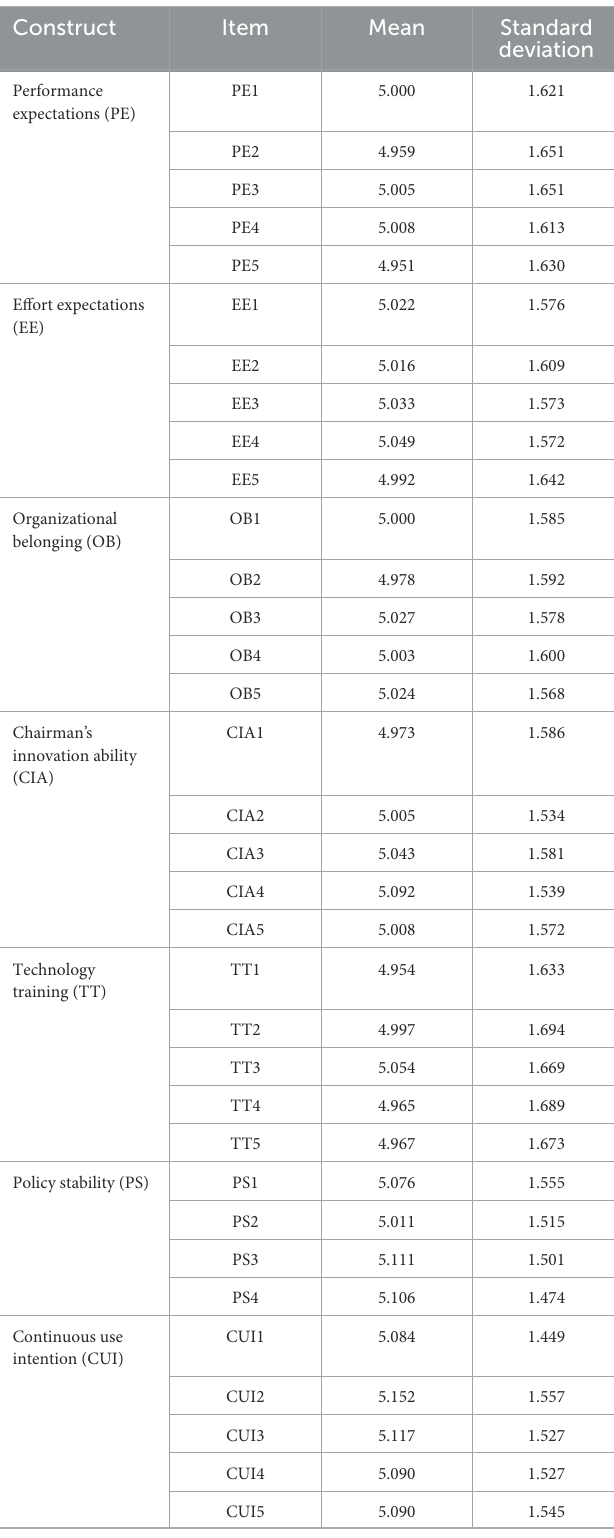
TABLE 1 Question item